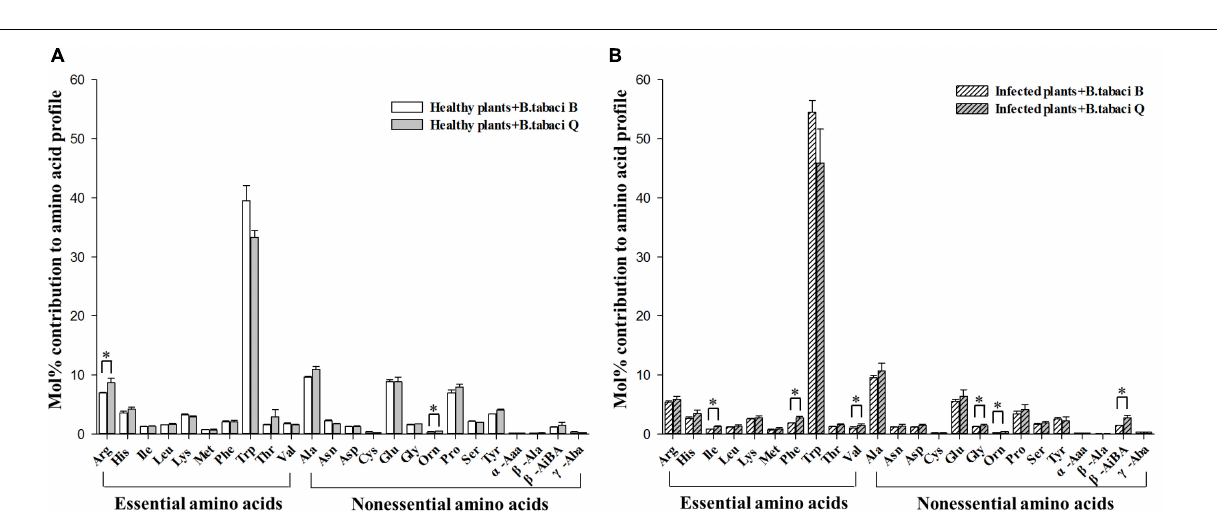
the virus infection significantly affected the mol% of the essential amino acid Phe in adults ( Table 1